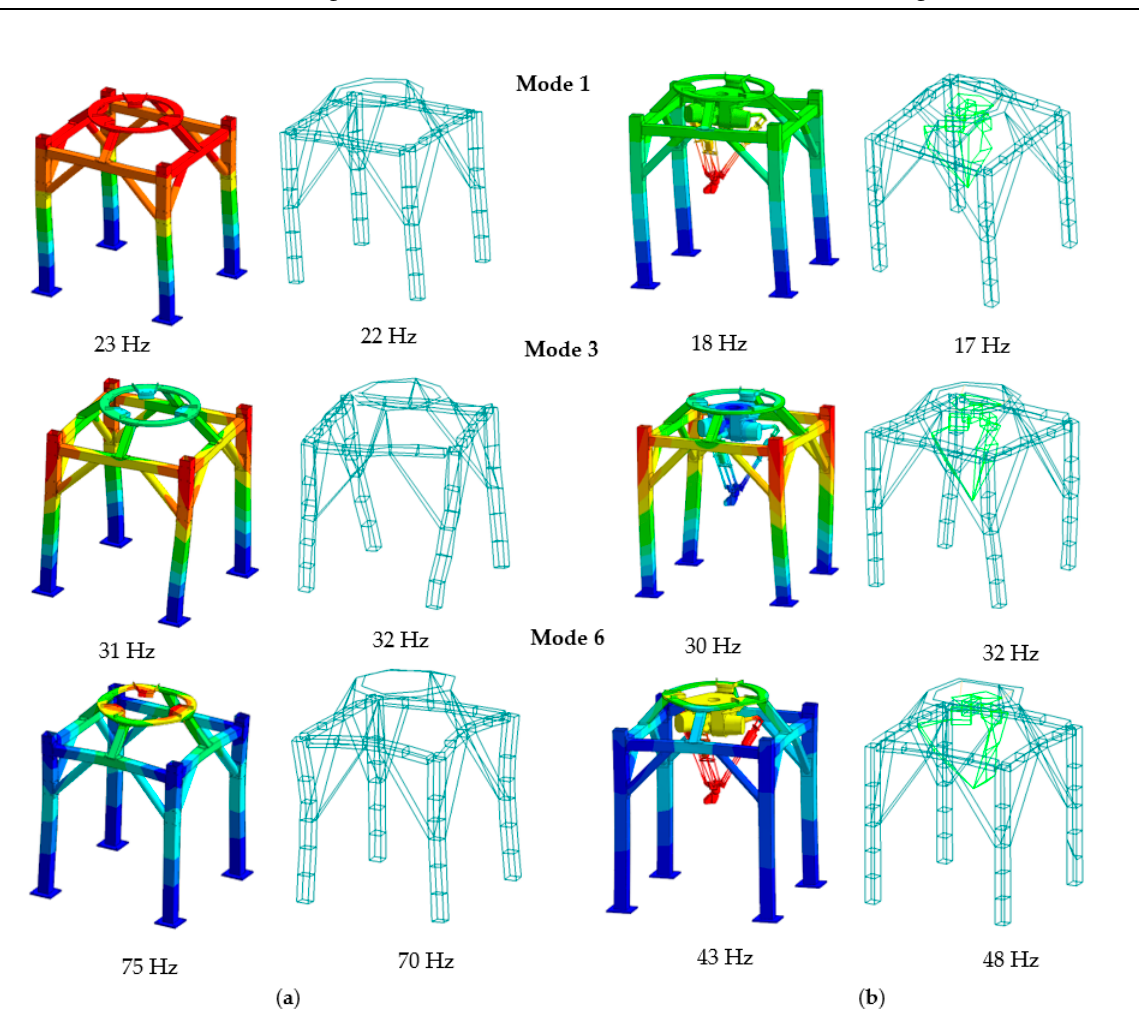
Figure 4. Selected mode shapes comparison ( a ) for the frame and ( b ) for the frame with the robot.